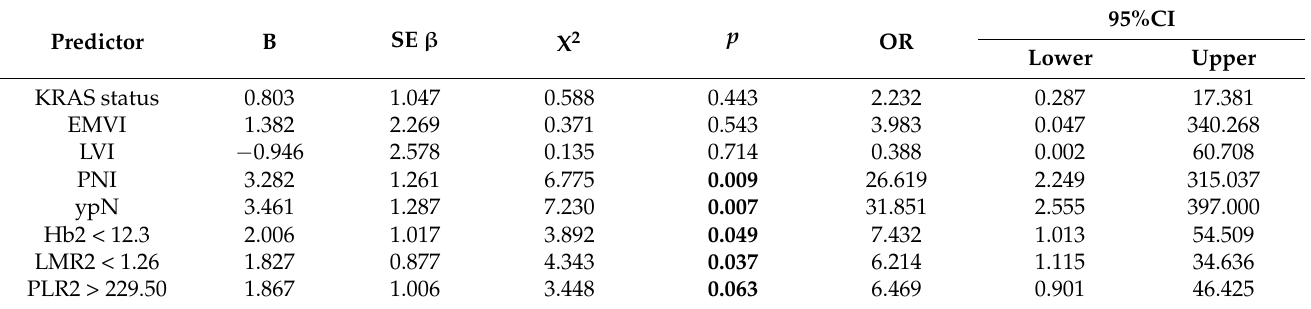
Table 4. Logistic regression based on relapse.